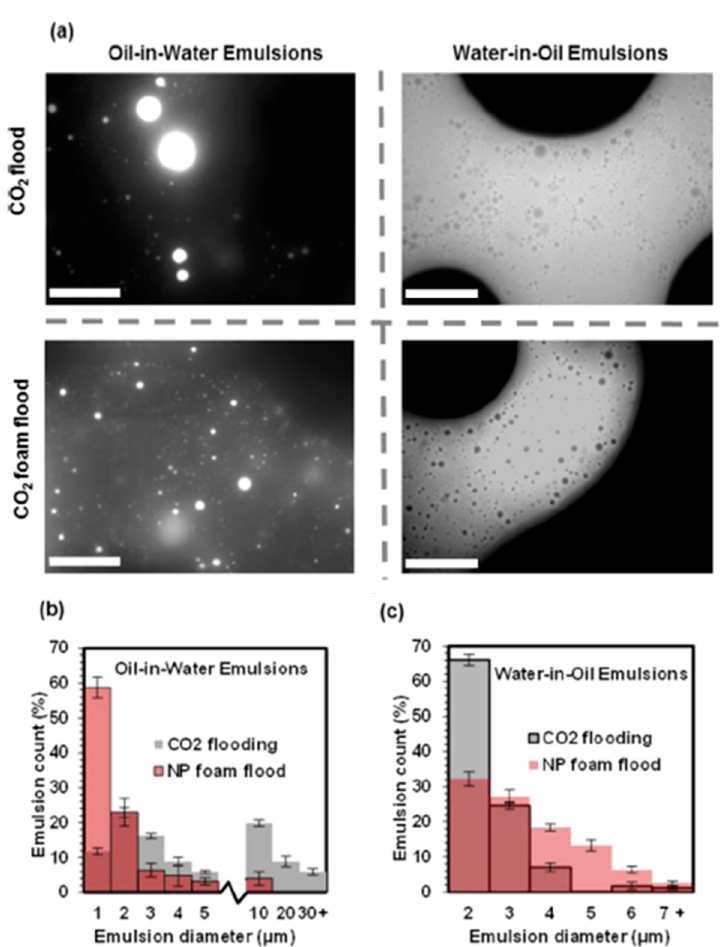
Figure 16. Micrometer-scale quantification of emulsion sizes: ( a ) images of o/w and w/o emulsions produced by a CO 2 flood and a NP-stabilized CO 2 foam flood; ( b ) size distribution of oil-in-water emulsions; ( c ) size distribution of water-in-oil emulsions [137].